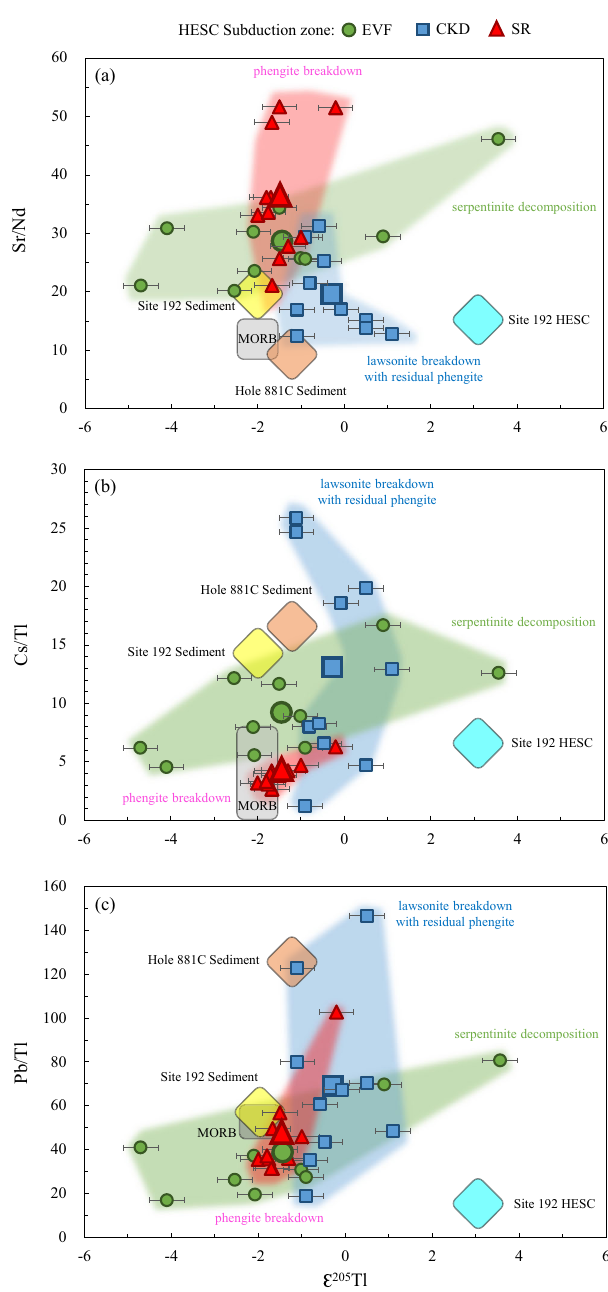
Fig. 7 | Trace element and Tl isotope compositions indicating progressive breakdown of different minerals at sub-arc depth. Thallium isotope composi- tionsplottedversus( a )Sr/Nd,( b )Cs/Tland( c )Pb/TlforKamchatkalavaswithinthe zone of Hawaii-Emperor Seamount Chain (HESC) subduction. The lavas have been fi ltered for degassing and deep ocean-island-basalt (OIB) components (see dis- cussion for details). Green, blue and red areas in each plots indicate serpentinite decomposition, lawsonite breakdown and phengite breakdown beneath Eastern Volcanic Front (EVF), Central Kamchatka Depression (CKD) and Sredinny Ridge (SR), respectively. See discussion for details. Large symbols indicate the average trace element ratio and Tl isotope compositions for each of the three sample